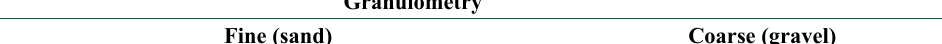
Table 2. Characterization of